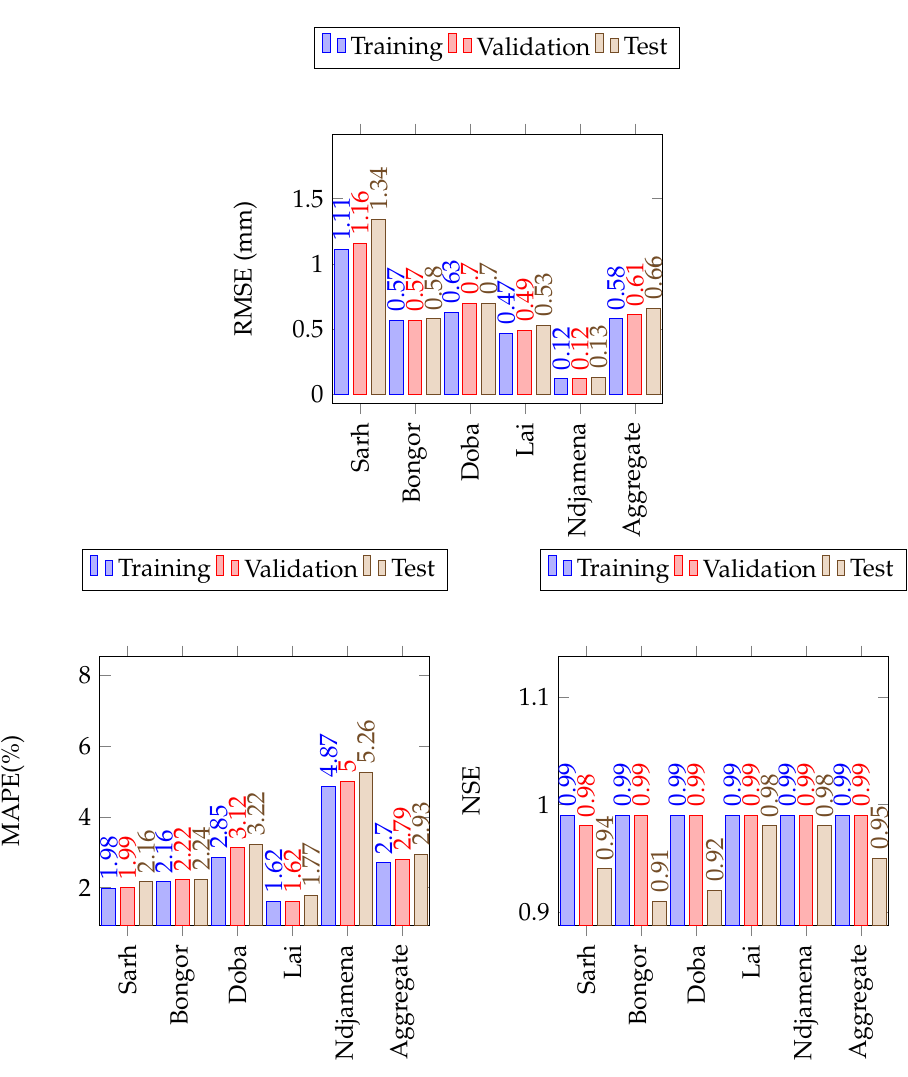
Figure 10. The LSTM model performance on the training, validation and test sets of minimum temperature in the Lake Chad Basin. The number of simulations run were 20 in all